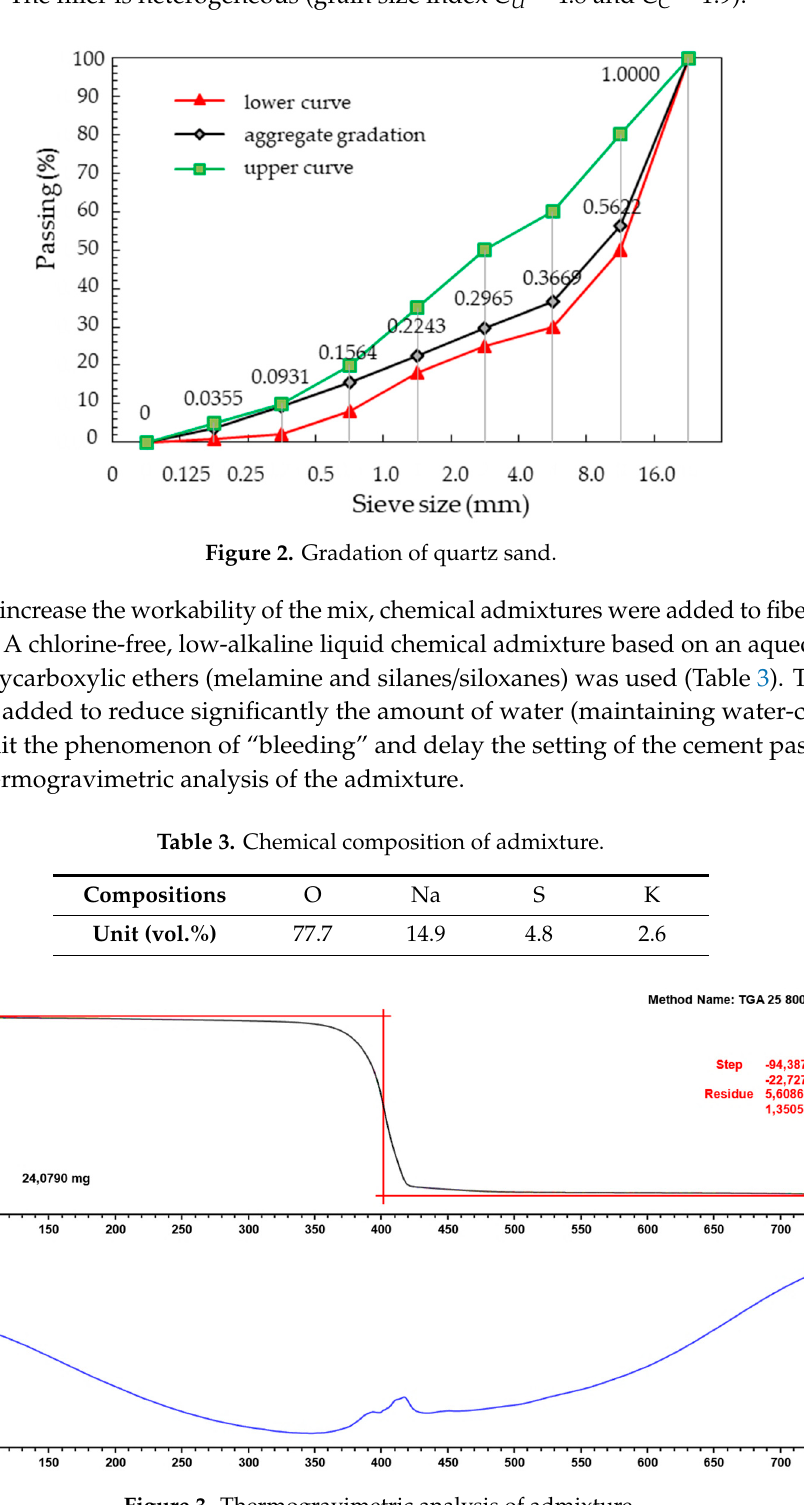
Figure 3. Thermogravimetric analysis of admixture.